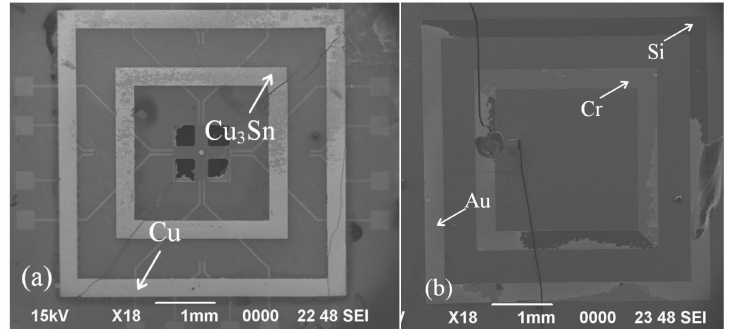
Figure 14. SEM images of the fracture surfaces for bonded device. ( a ) Cu–Sn bonding. ( b ) Au–Au